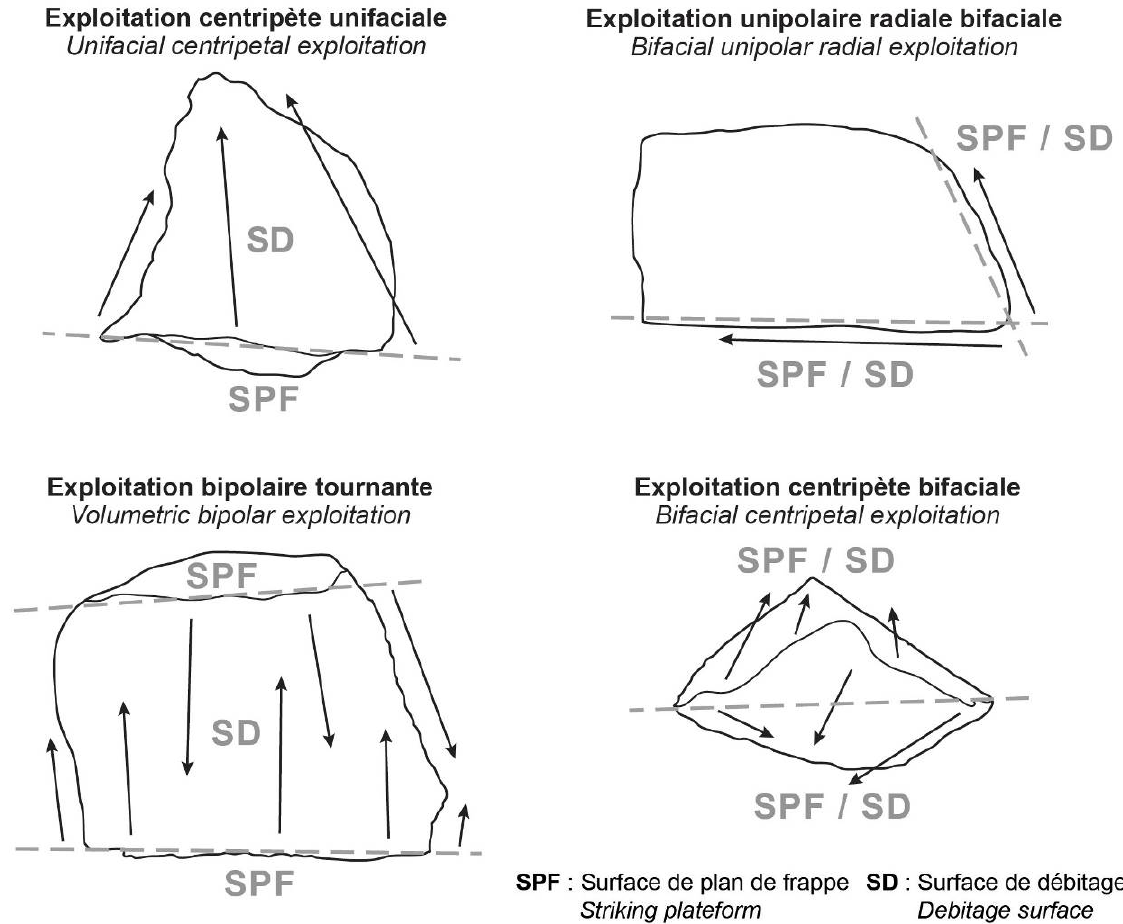
Figure 10. Nucléus de Tanataetea. Figure 10. Tanataetea